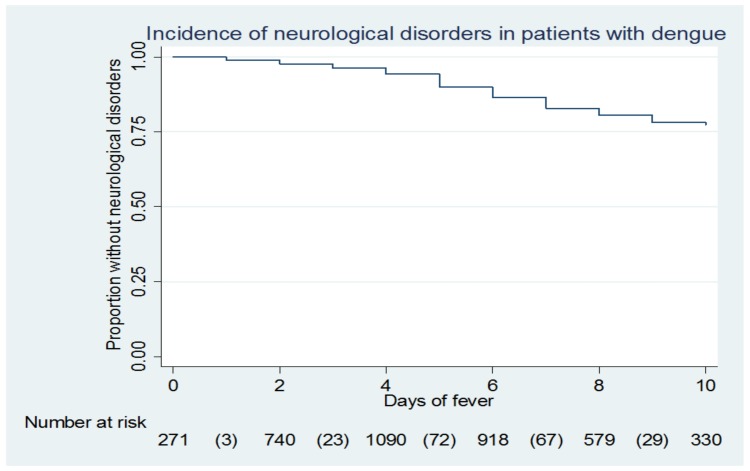
“Kaplan Meier curve for neurological disorder during dengue fever”.